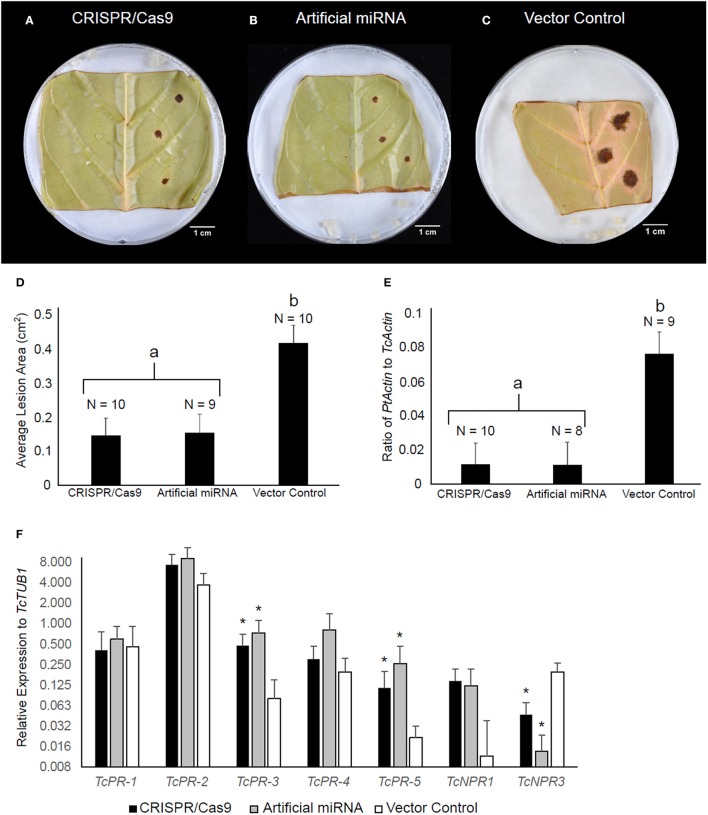
TcNPR3 mutagenesis by CRISPR/Cas9 increases resistance to Phytophthora tropicalis in detached cacao leaf. Representative photographs of P. tropicalis inoculated leaves transformed with (A) pGSh16.1010 (TcNPR3 CRISPR/Cas9 system) (B) pGS12.0225 (TcNPR3 artificial miRNA), and (C) pGSh16.1012 (vector control). (D) Bar graph of lesion size analysis. Bars represent mean lesion size and error bars represent standard error. N represents number of samples across three experimental repetitions. Letter labels indicate statistically significantly differing treatments (t-test p < 0.05). (E) Bar graph of DNA ratio analysis. Bars represent mean ratio of P. tropicalis actin to T. cacao actin and error bars represent standard error. N represents number of samples across three experimental repetitions. Letter labels indicate statistically significantly differing treatments (t-test p < 0.05). (F) Relative expression of defense-related genes after transient transformation and P. tropicalis inoculation. Bars represent mean expression value across nine samples from three experimental repetitions, and error bars represent standard error. Asterisks indicate statistically significant increase in expression relative to vector control treatment detected in REST (Pfaffl et al., 2002).